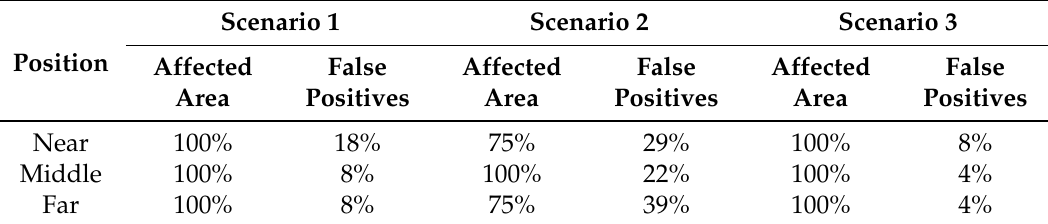
Table 2. Detection of affected zone and false